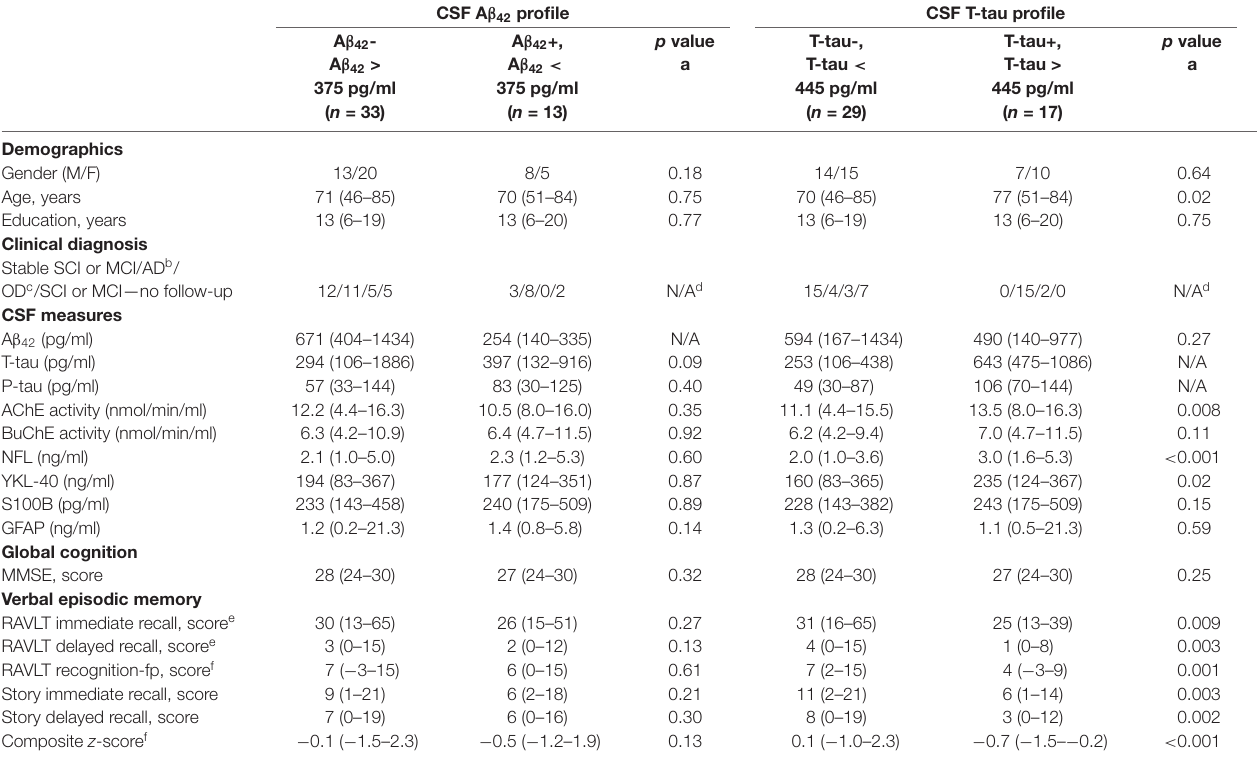
TABLE 1 | Subject demographics, CSF marker levels, and cognitive scores by CSF A β 42 and T-tau